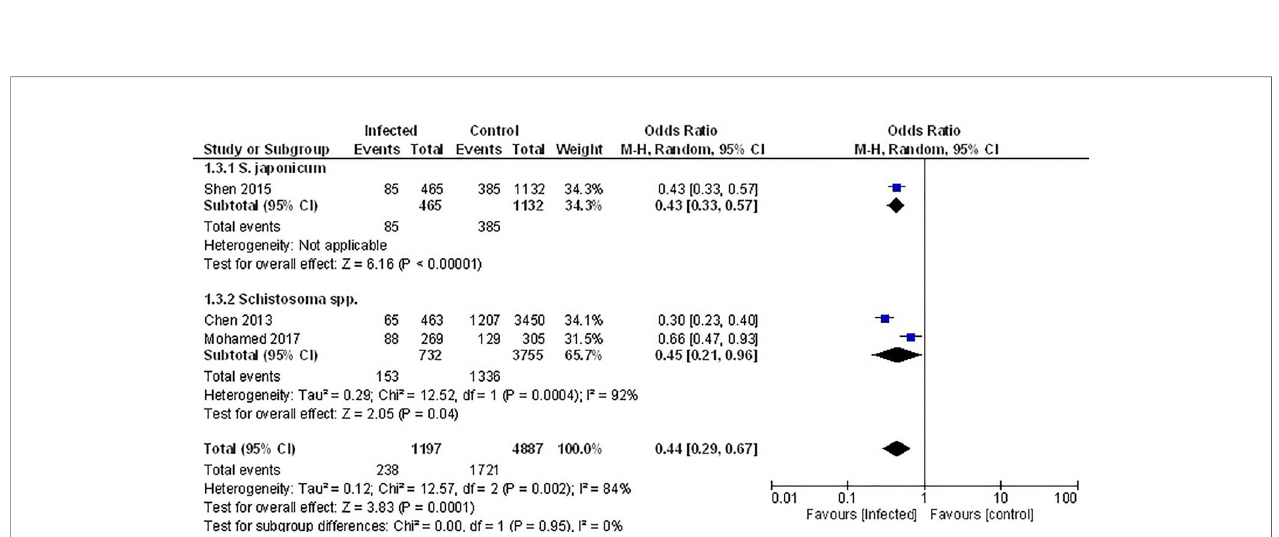
FIGURE 4 | Effect of infection on the prevalence of the metabolic syndrome. Forest plot of studies which both individually and taken as a whole, demonstrate the protective effect of infection on prevalence of the MetS.